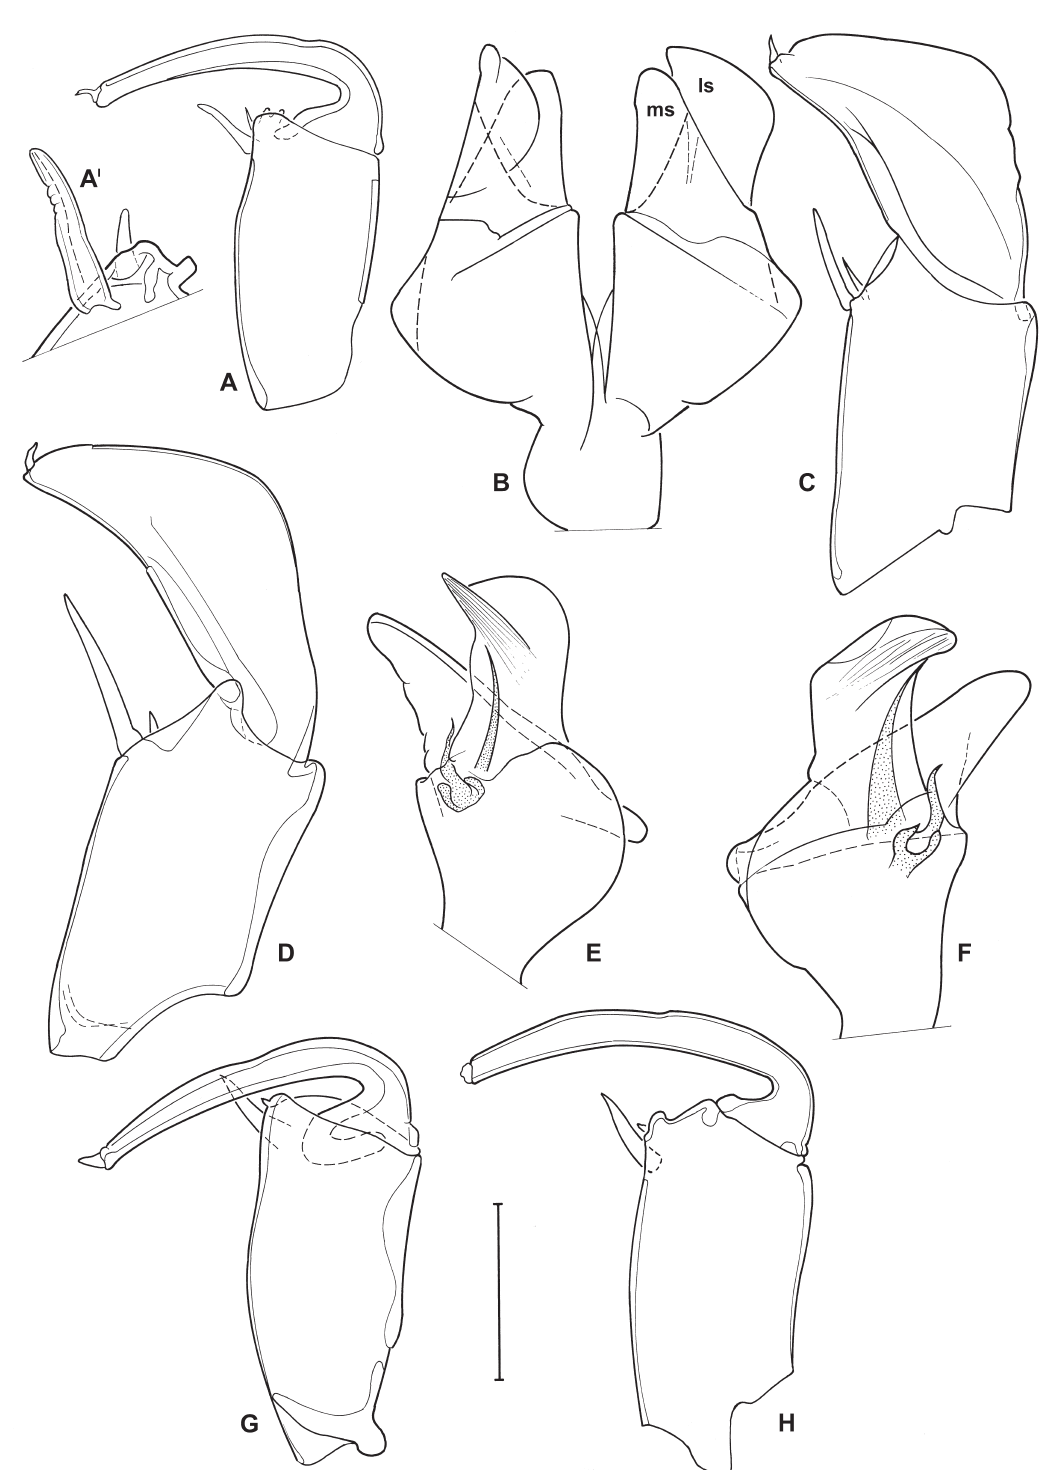
Fig. 17. A - C . Bennelongia lata sp. nov. (holotype ♂, WAM.C49399); D - H . Bennelongia cuensis sp. nov. (D-G = holotype ♂, WAM.C49406; H = OC.3319). A . Left prehensile palp and detail of apical sensory organs on first segment. B . outline of hemipenes (note that distal shield is folded in left hemipenis). C . right prehensile palp. D . right prehensile palp. E . Outline of hemipenis. F . Outline of second hemipenis, same individual. G . Left prehensile palp. H . Left prehensile palp. Scales: B, E, F = 232 µm,; A, C, D, G, H = 92 µm; A’ = 37